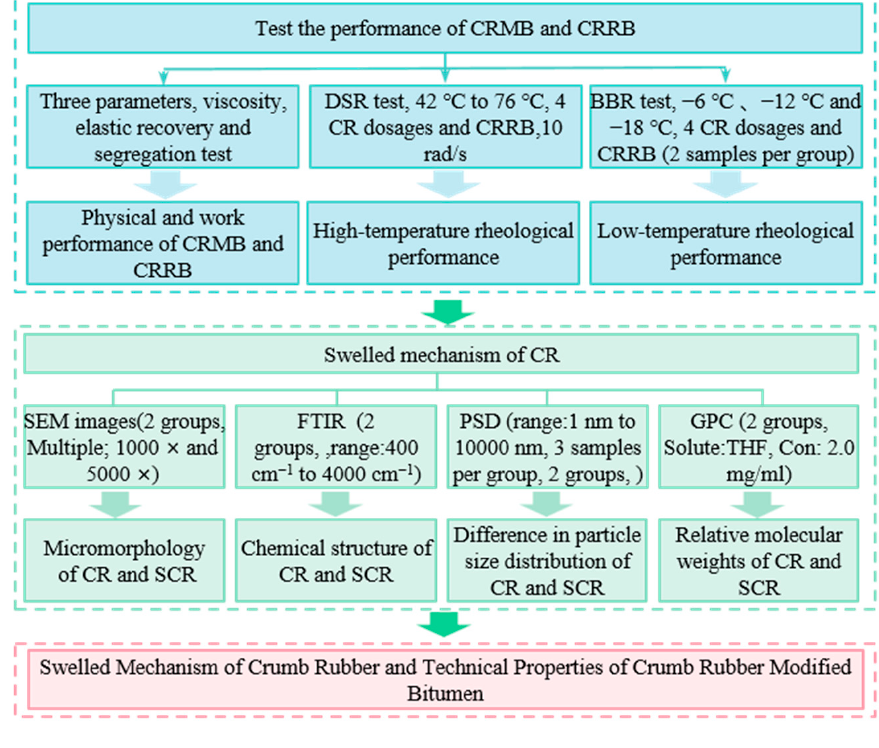
Figure 2. Technical